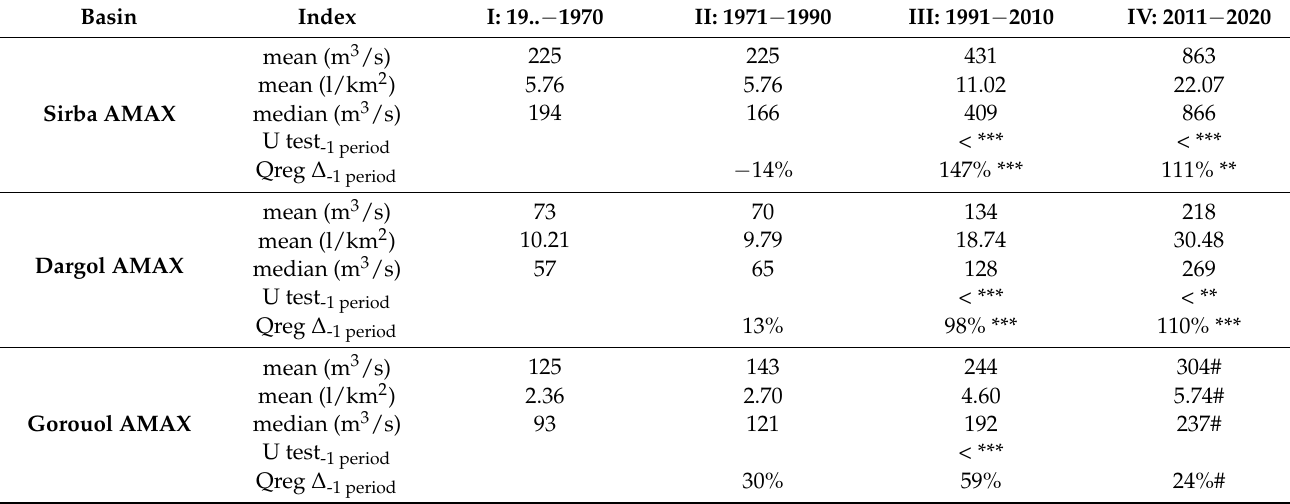
Table 9. Data series segmentation (fixed periods): mean, median and difference of AMAX of the main Sahelian tributaries. For non-normal distributed variables, the Wilcoxon–Mann–Whitney test (U-test) and the quantile regression (Qreg) were used. The ∆ -1 period is the difference (%) between the period and the previous ones. Significance of changes: *** p < 0.01,